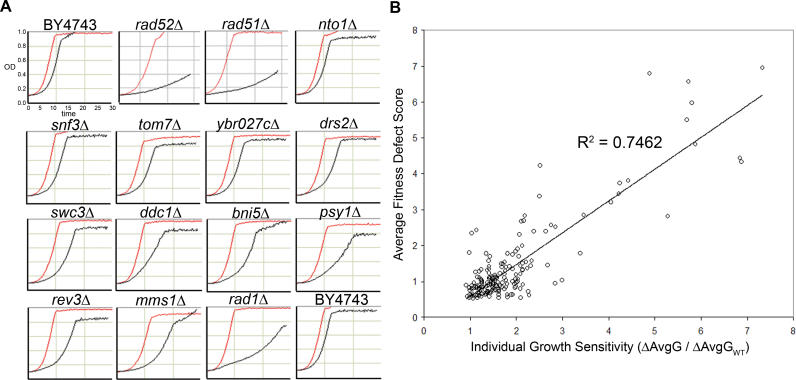
Comparison of Individual Strain Analysis to Microarray Results(A) Representative growth curves of 16 individual strains grown in the presence of solvent alone (DMSO, red curve) and 62.5 μM mechlorethamine (black curve). Growth was monitored by measuring the optical density (OD600) of cultures every 15 min for 30 h. The fitness of each strain was defined by the difference between the average doubling times in mechlorethamine and in DMSO (see Materials and Methods).(B) Correlation between growth rates of individual strains and microarray-based fitness estimates. The ratio of growth rates of the 186 individual homozygous deletion strains (the top 233 ranked mechlorethamine-sensitive strains as determined by three replicate microarray experiments minus 47 strains which exhibited a slow-growth phenotype when individually cultured in the absence of mechlorethamine) over an average wild-type growth rate are plotted on the x-axis against the average fitness-defect scores from three pool experiments on the y-axis. The correlation (R
2 = 0.7462) is highly significant (p = 5.4e−57).